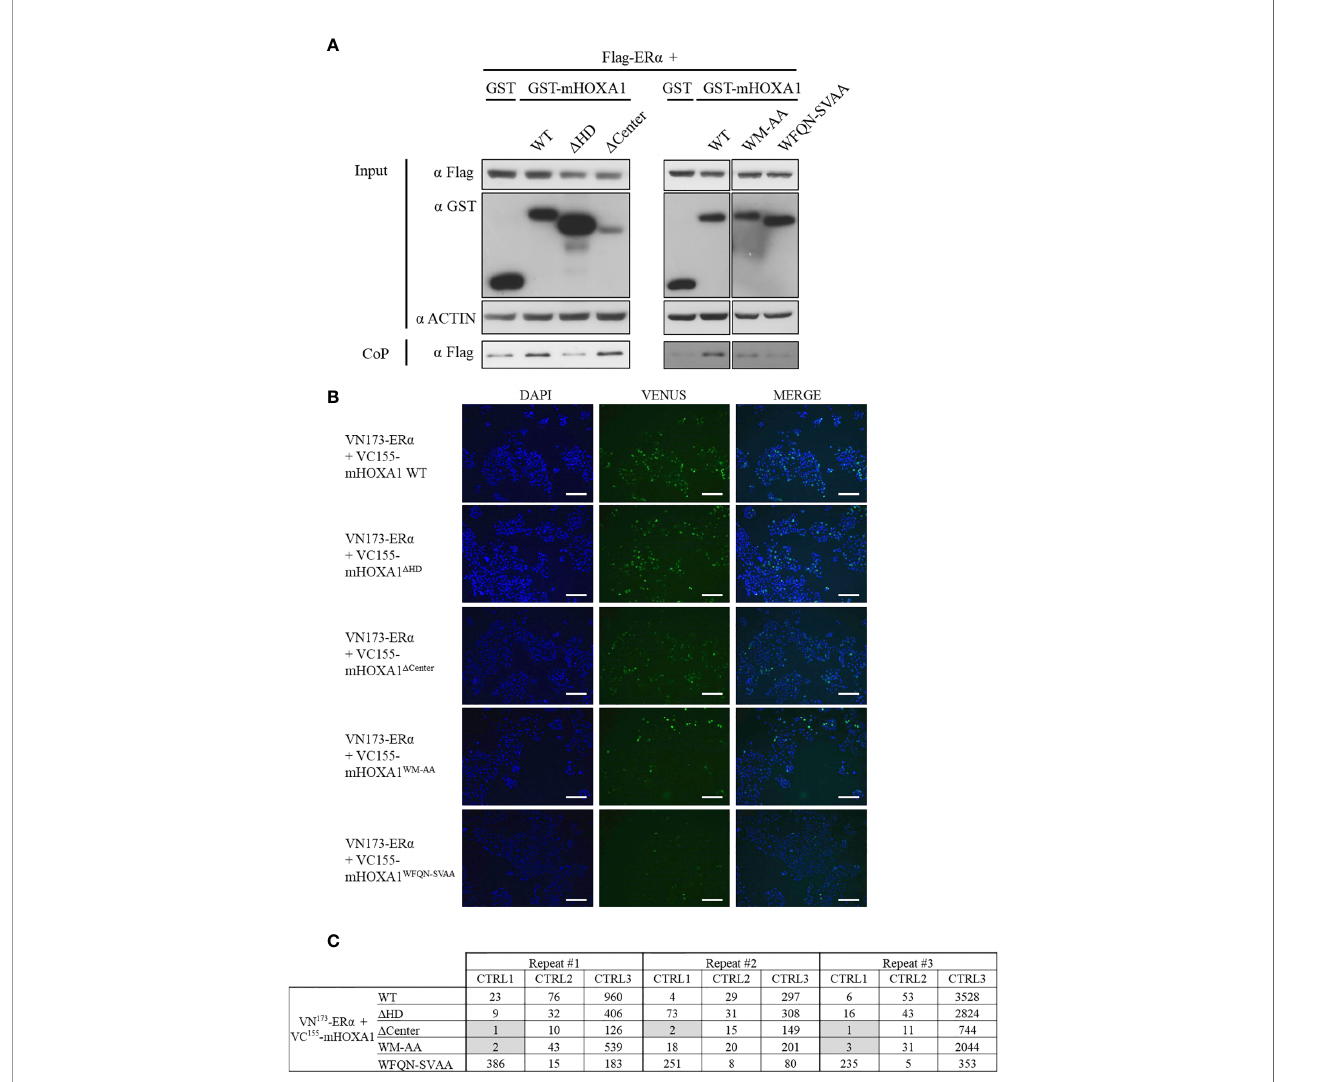
FIGURE 6 | Mapping of HOXA1 regions involved in the HOXA1-ER a interaction. (A) For co-precipitation, HEK293T cells were transfected with plasmids encoding Flag-ER a and GST, GST-mHOXA1 WT, GST-mHOXA1 D HD , GST-mHOXA1 D Center , GST-mHOXA1 WM-AA and GST-mHOXA1 WFQN-SVAA , respectively. GST-mHOXA1 WT interacts with Flag-ER a and the deletion of the central part of HOXA1 does not affect the interaction (N>3). GST-mHOXA1 D HD loses the interaction with Flag-ER a (N>3). GST-mHOXA1 WM-AA and WFQN-SVAA show weaker interaction with Flag-ER a (N=3/5). (B) For BiFC, COS7 cells were transfected with plasmids encoding VN173-ER a and VC155-mHOXA1 WT, VC155-mHOXA1 D Center , VC155-mHOXA1 D HD , VC155-mHOXA1 WM-AA and VC155-mHOXA1 WFQN-SVAA , respectively. VC155- mHOXA1 interacts with VN173-ER a . VC155-mHOXA1 D HD interacts with VN173-ER a similarly to the wild type. VC155-mHOXA1 D Center , VC155-mHOXA1 WM-AA and VC155-mHOXA1 WFQN-SVAA display weaker BiFC signal than the wild type VC155-mHOXA1 (N=3, n=2). Scale bars represent 200 µm; N, number of experiments; n, number of replicates per experiment. (C) BiFC quanti fi cation. Fluorescence ratios between the tested condition and the negative control pDest VN173 + VC155- mHOXA1 (CTRL1); the tested condition and the negative control VN173-ER a + pDest VC155 (CTRL2); the tested condition and the negative control pDest VN173 + pDest VC155 (CTRL3). A three-fold increase in fl uorescence signal between negative controls and tested conditions was applied as a minimal threshold to conclude for an interaction. Grey boxes indicate where the threshold of >3 is not